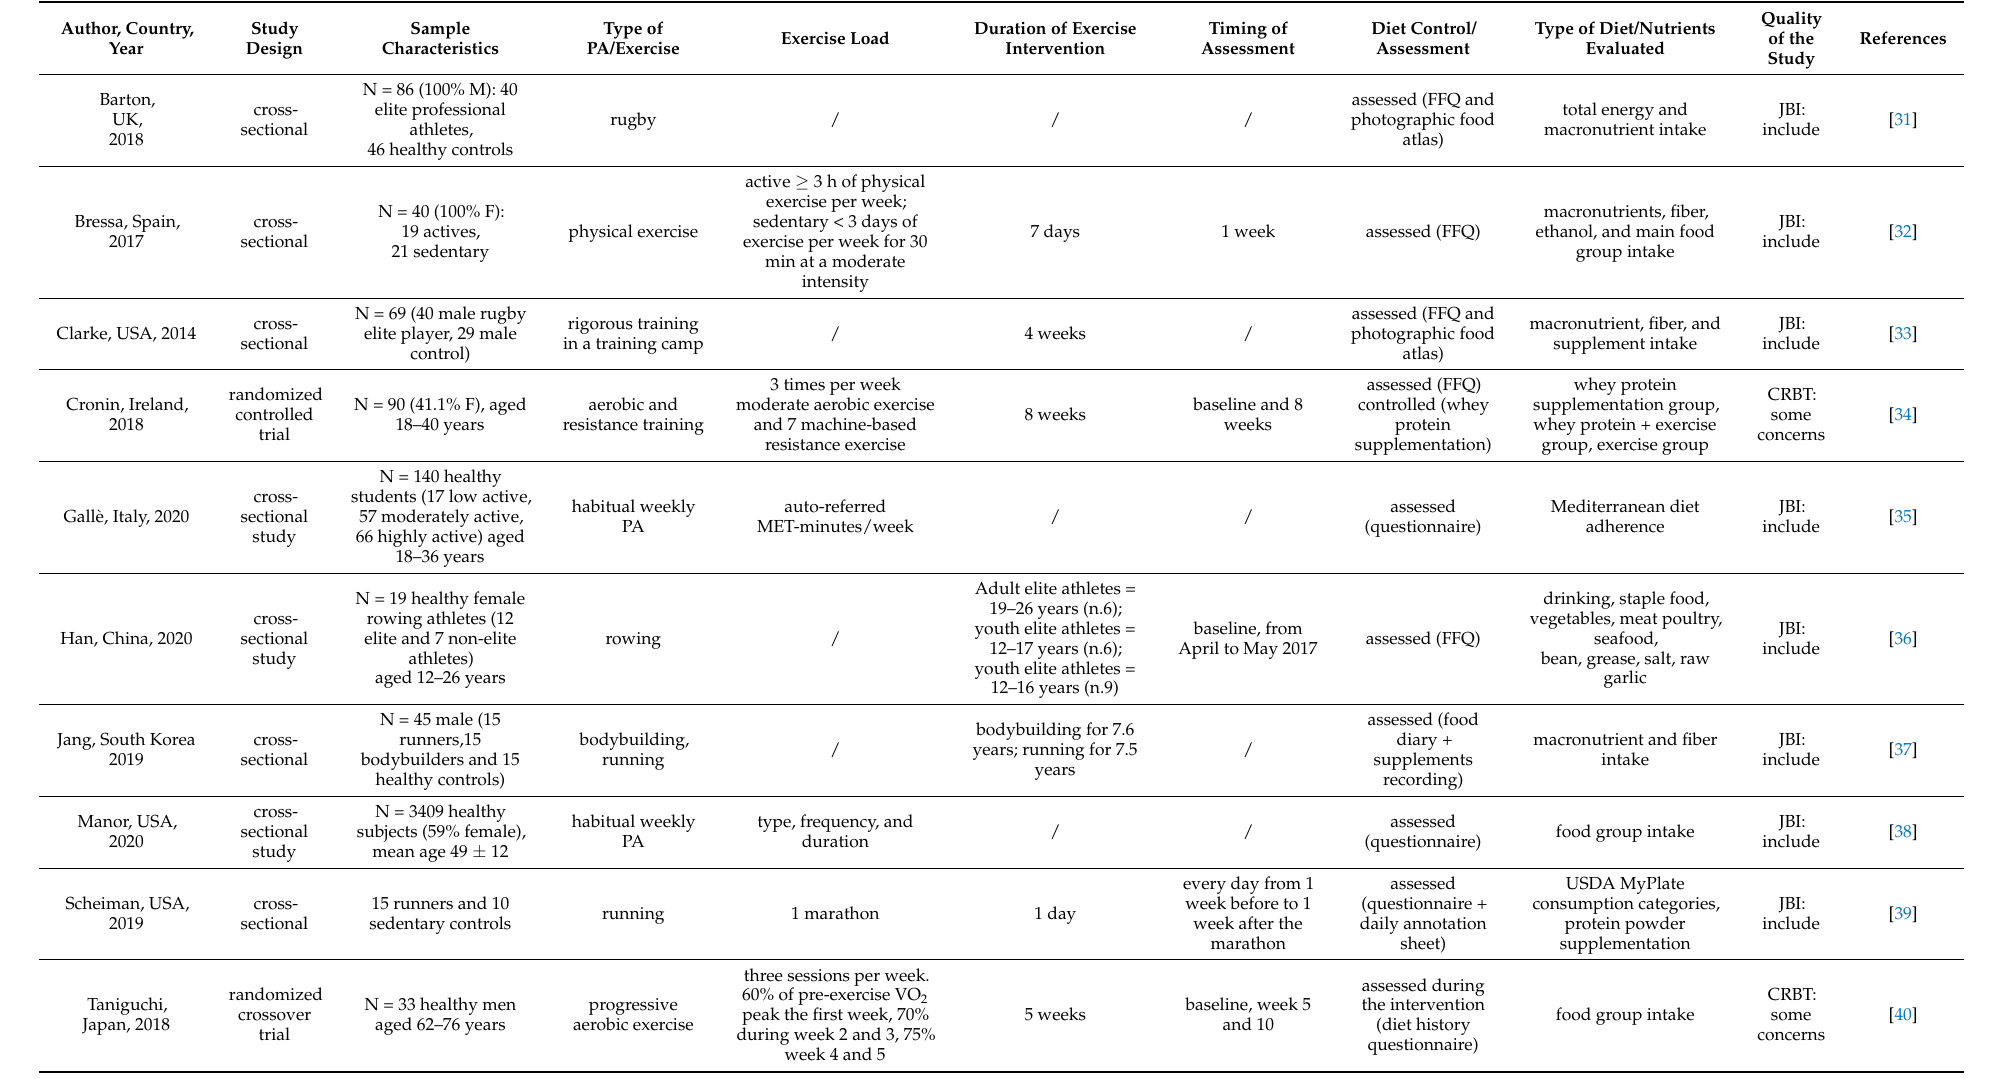
Table 1. Characteristics of the selected